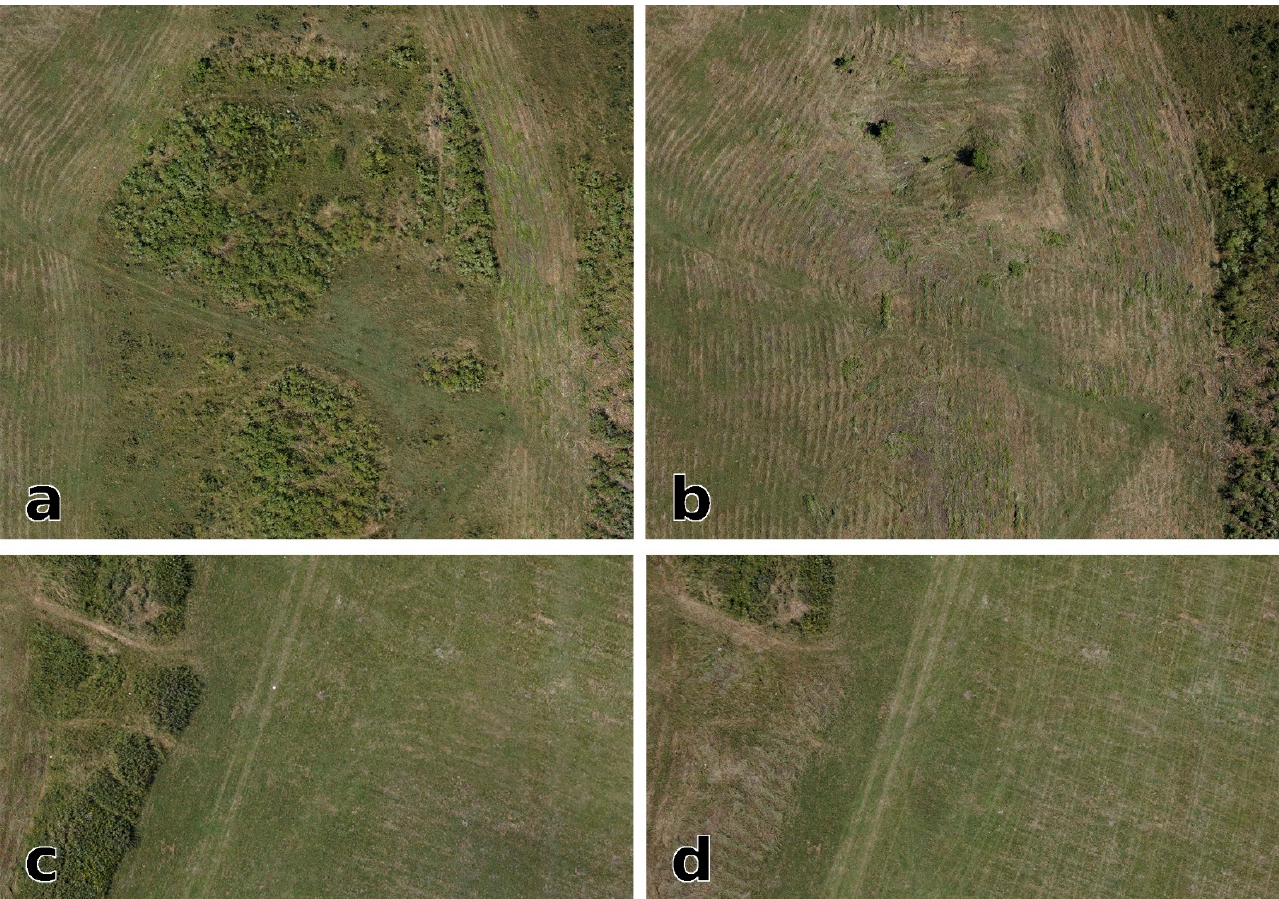
Figure 8. During Bassianae 's UAS survey, the scene was anything but spatially invariant. Images ( a , b ) cover the same scene, but they look quite different, which illustrates some of the severe surface changes that occurred due to vegetation clearing. These changes are also observable on the left sides of insets ( c , d ). The grass patterns resulting from the geophysical survey were less obtrusive (compare the right sides of ( c , d )).